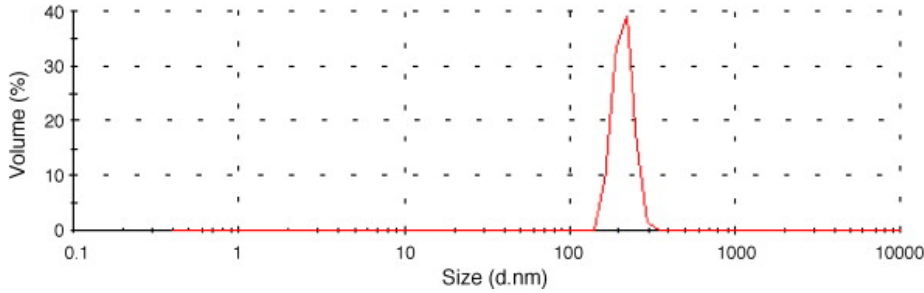
Figure 3. Particle size distribution of PCL and rosemary extract obtained by the SAS process. Reprinted with permission from [78] . Copyright © 2022 Elsevier.